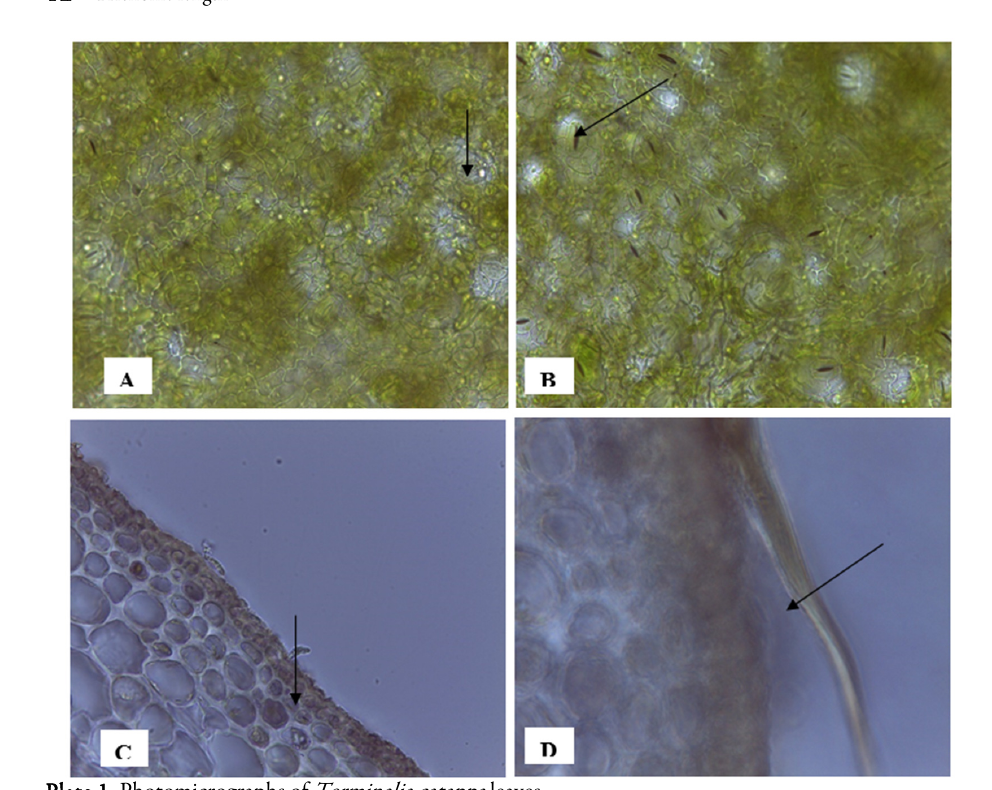
Mean± SE in the same column with different letters in superscript are significantly different (P < 0.05), SN =